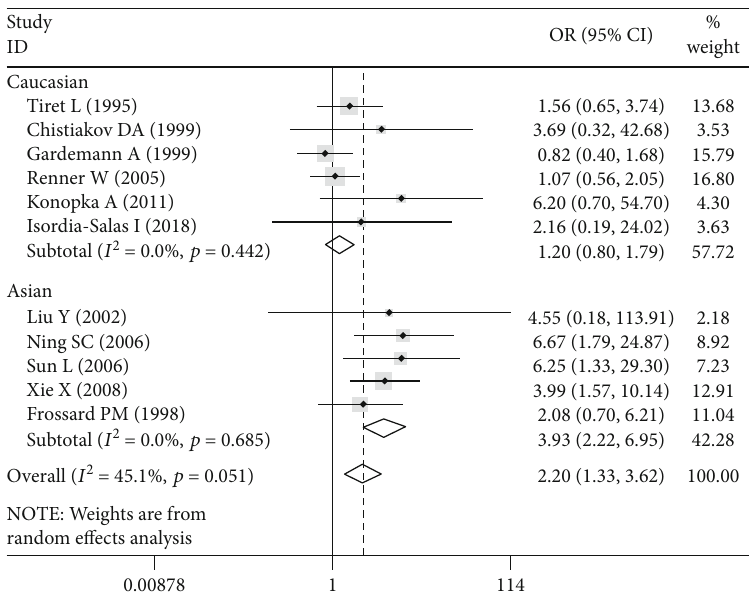
Figure 3: Forest plot of AGT p.Thr174Met polymorphism associated with myocardial infarction strati fi ed by ethnicity using a codominant genetic model (MM vs.